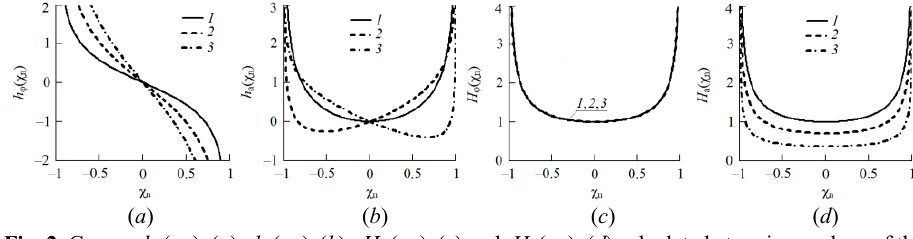
( a ) ( b ) ( c ) ( d ) Fig. 2. Curves ( χ ) h ( b ), ( χ ) H ( d ) calculated at various values of the ( χ ) h ( a ), ( χ ) H ( c ) and a n a n φ n φ n coefficient γ : γ 1.5  (curves 1 ), γ 0  (curves 2 ), γ 2.5   (curves 3